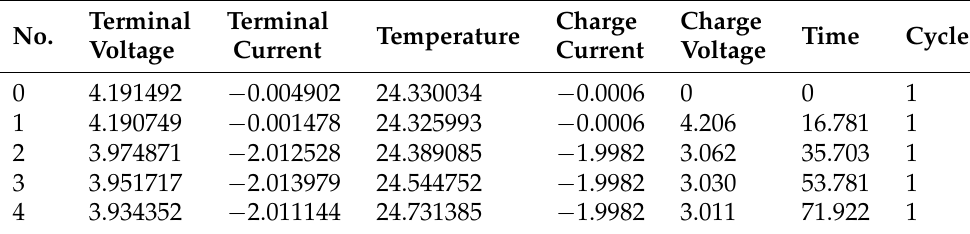
Figure 5. Capacity degradation curves of cells 3. Table 4. Overview of